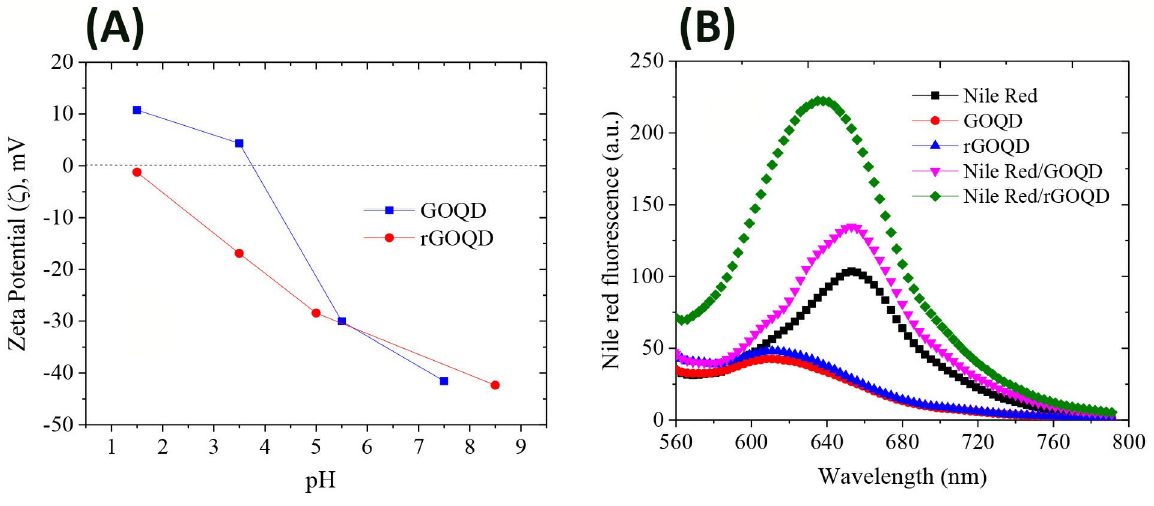
Fig 3. Zeta potential and surface hydrophobicity measurements of GOQDs and rGOQDs. (A) Zeta potential changes of 0.2 mg/ml GOQDs and rGOQDs in a range of pH (1.5–8.5); (B) Fluorescence intensity of Nile red in the absence and presence of 2 mg/ml GOQDs and rGOQDs. The fluorescence spectra of GOQDs and rGOQDs excited at 530 nm are also